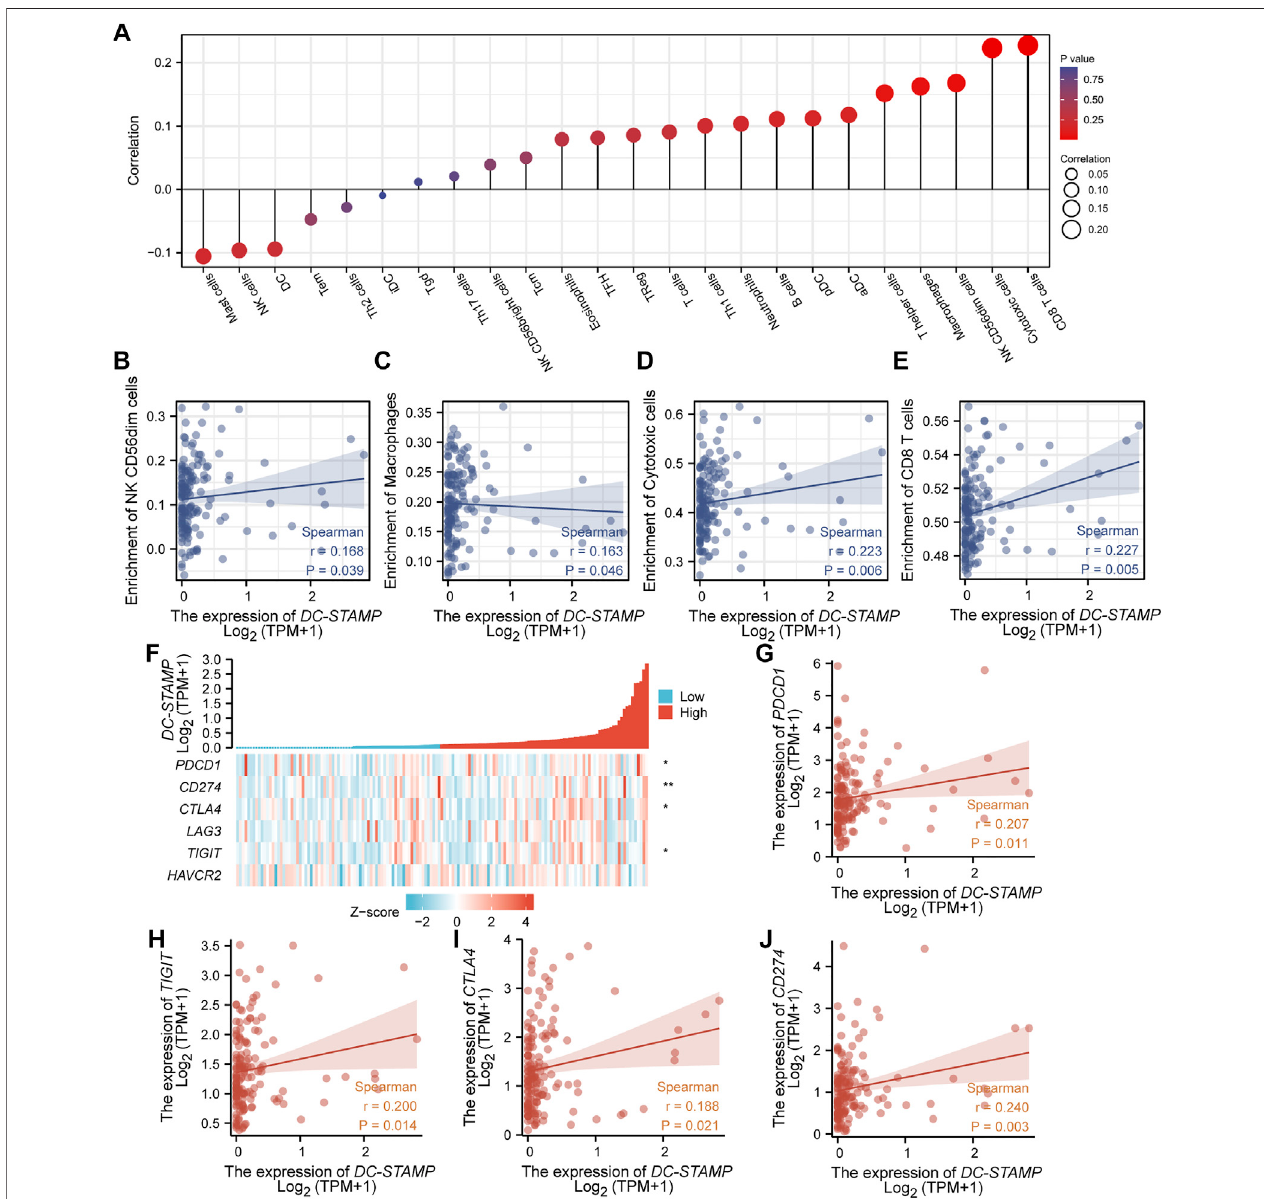
FIGURE 6 | Correlation analysis between the level of DC-STAMP gene expression and immune cell in fi ltration or immune checkpoint molecules. (A) Association between DC-STAMP expression and 24 kinds of in fi ltrated immune cells. (B – E) Using Spearman ’ s correlation in quanti fi ed analysis of the correlation of DC-STAMP expression with in fi ltrating level of ( B ) NK CD56 (dim) cells, (C) macrophages, (D) cytotoxic cells and (E) and CD8 (+) T cells. (F) Association of DC-STAMP with fi ve immunecheckpointmolecules( PDCD1 , CD274 , CTLA-4 , LAG-3 , TIGIT ,and HAVCR2 ). (G – J) UsingSpearman ’ scorrelationinquanti fi edanalysisofthecorrelation of DC-STAMP expression with ( G ) PDCD1, (H) TIGIT, (I) CTLA-4, and (J) CD274 (r was Spearman ’ s correlation coef fi cient) (* p < 0.05, ** p < 0.01, *** p <